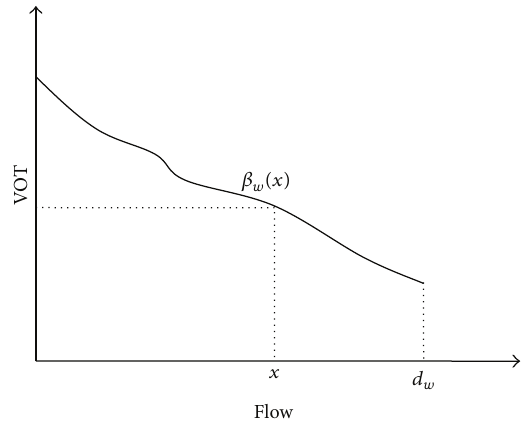
Figure 1: Continuously distributed VOTs for users between each OD pair 𝑤